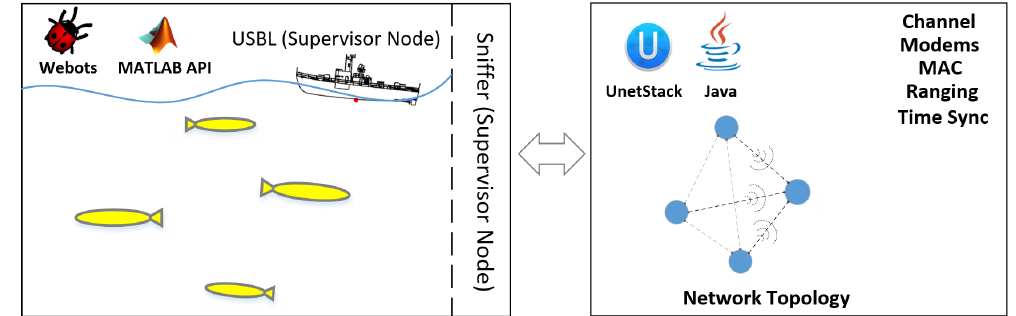
Figure 8. The implemented simulation platform used to validate the proposed navigation